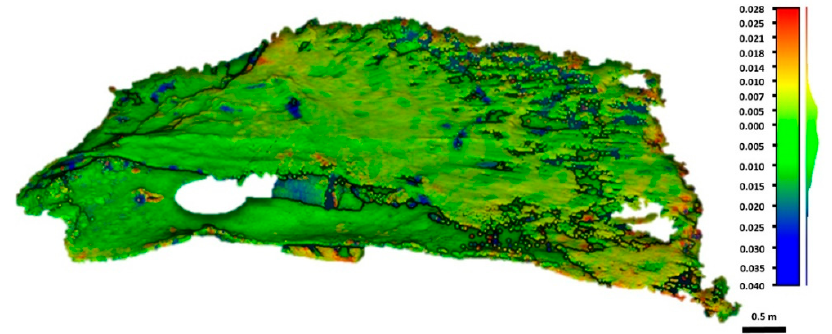
Figure 10. Discrepancies obtained from the comparison of the TLS and WMLS point clouds. It is observed that most of the WMLS point cloud shows a green-yellow color indicating that the discrepancies between the WMLS and the TLS are under or near 1 cm. Red and blue areas indicate zones on which the TLS was not able to capture information due to the complexity of the shelter.